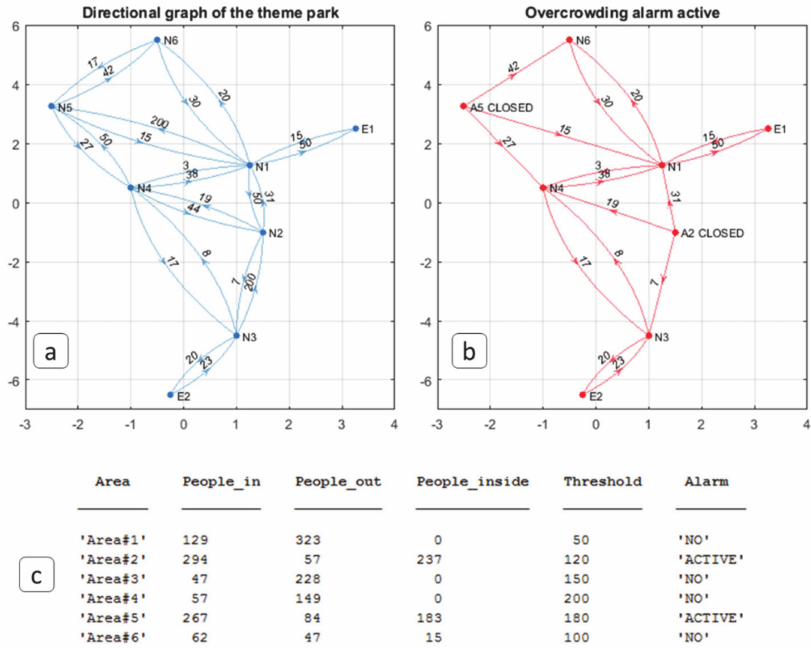
Figure 12. Example of the results of the Algorithm 3 in case of an overcrowding alarm at nodes 2 and 5, where ( a ) is the graph without an alarm, ( b ) is the graph in case of an alarm, and ( c ) is a table that shows the overall